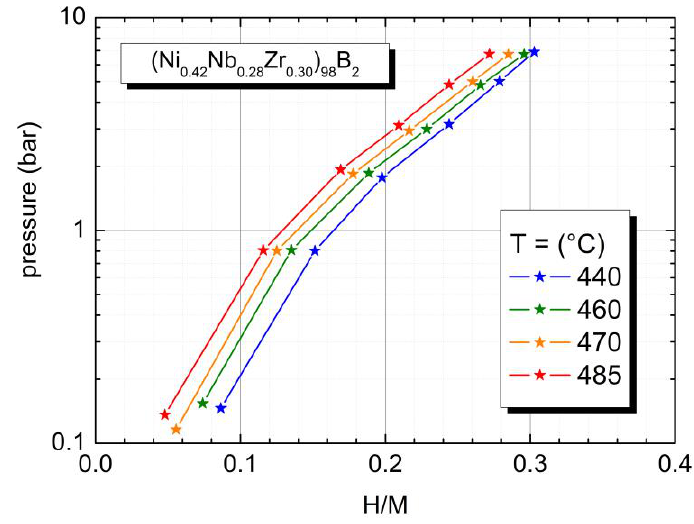
Figure 6. Pressure-composition isotherms of sample (Ni 0.42 Nb 0.28 Zr 0.30 ) 98 B 2 measured between 440 °C and 485 °C.